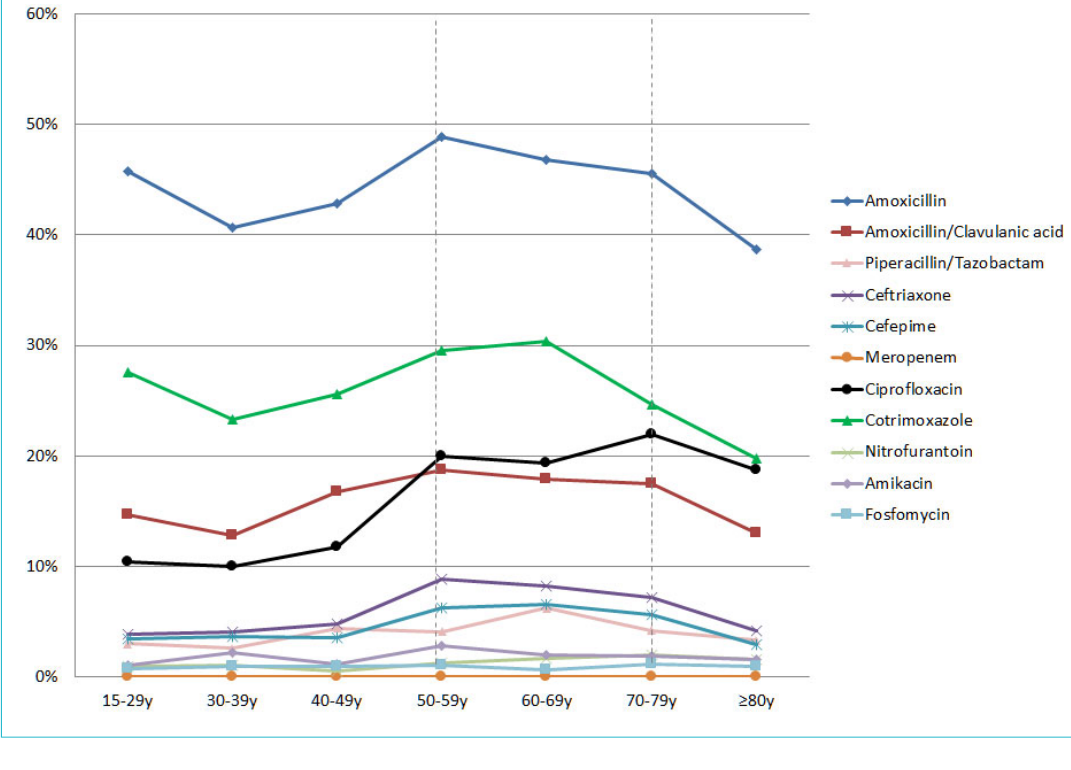
Crude OR (95% CI) p-value Adjusted OR (95% CI) p-value